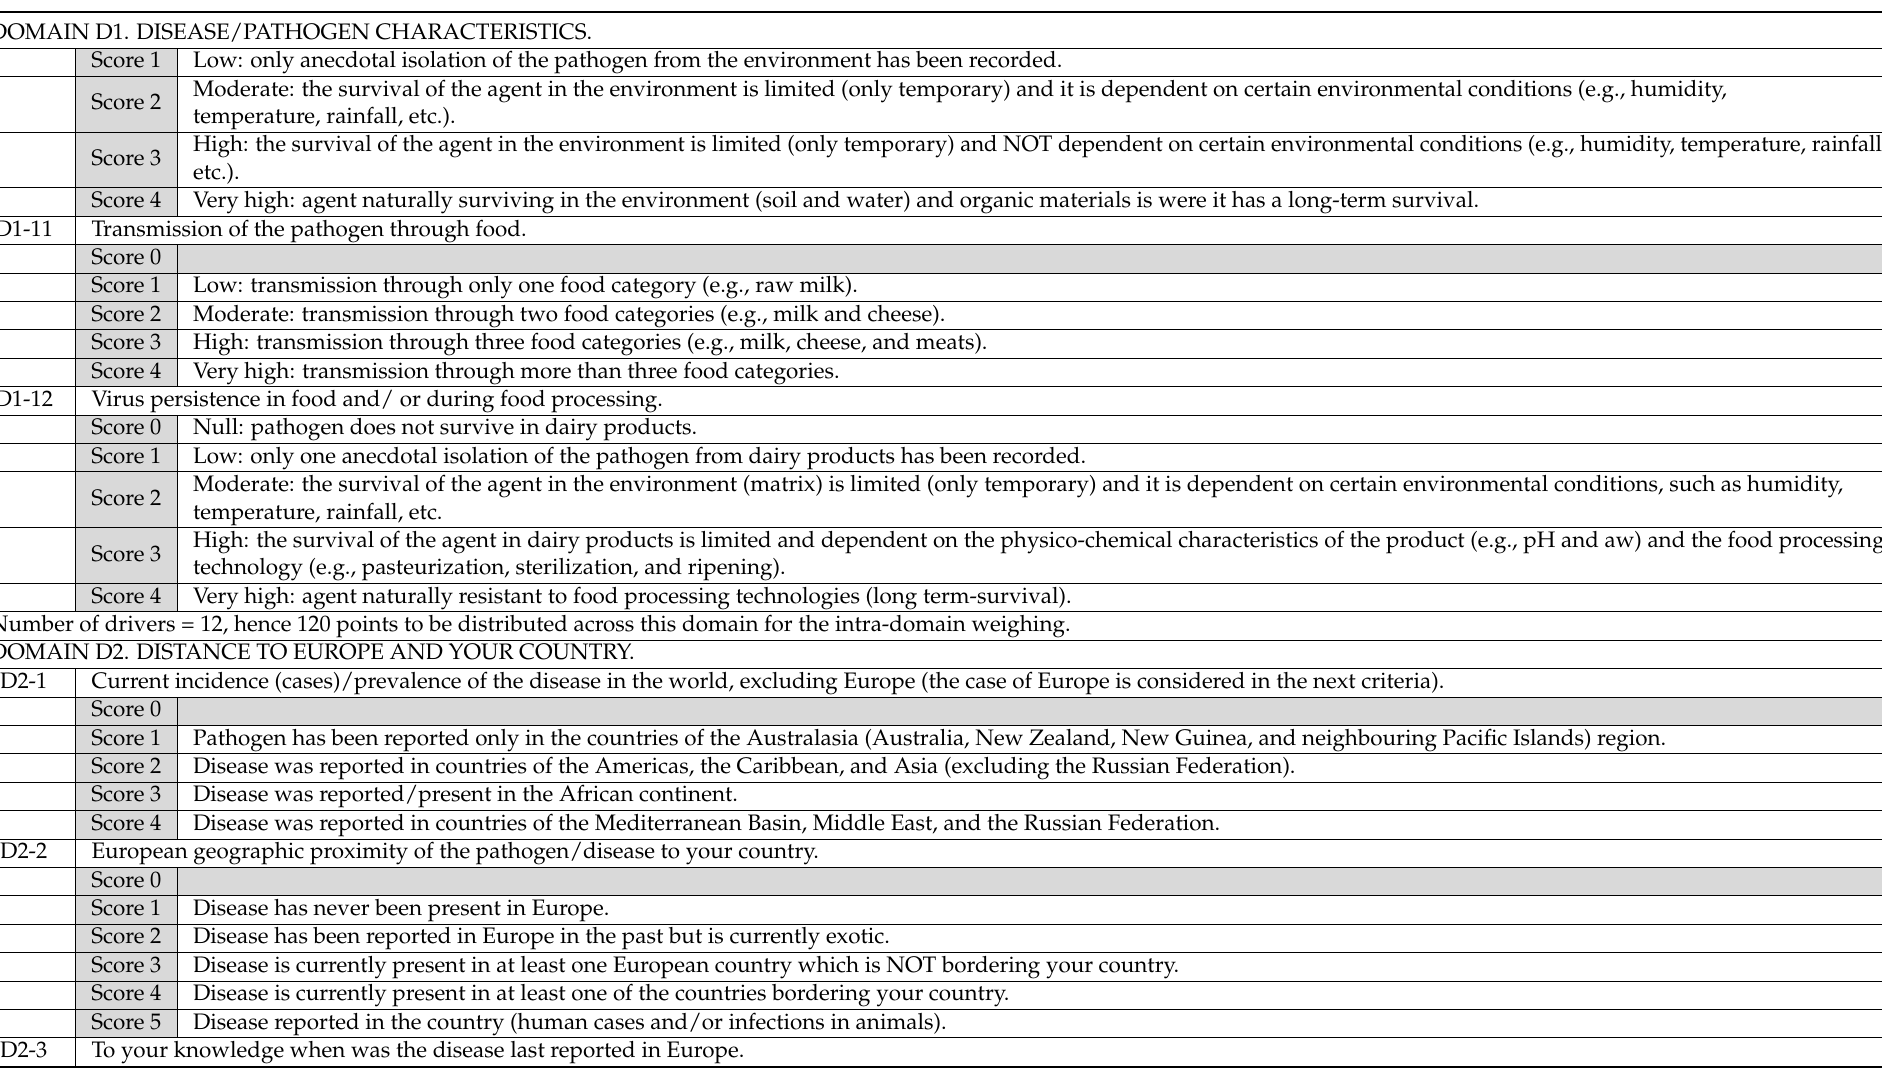
DOMAIN D1. DISEASE/PATHOGEN